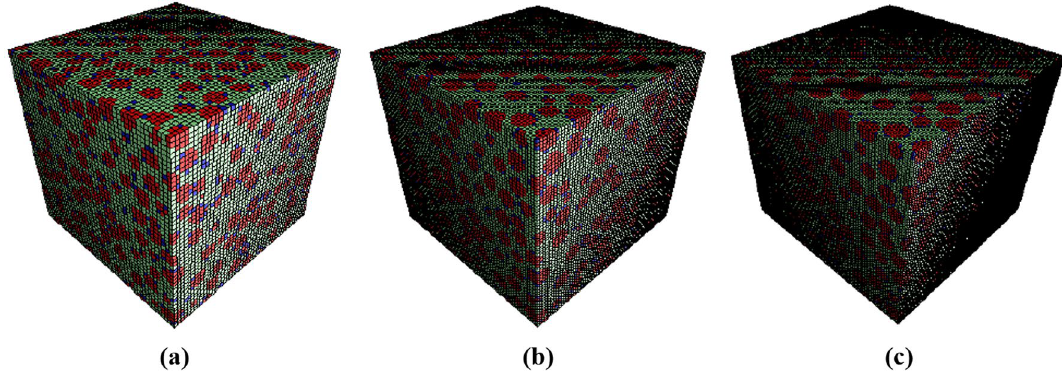
Figure 5. Mesh sizes at mesoscale: ( a ) 0.2, ( b ) 0.133, and ( c ) 0.1 mm.